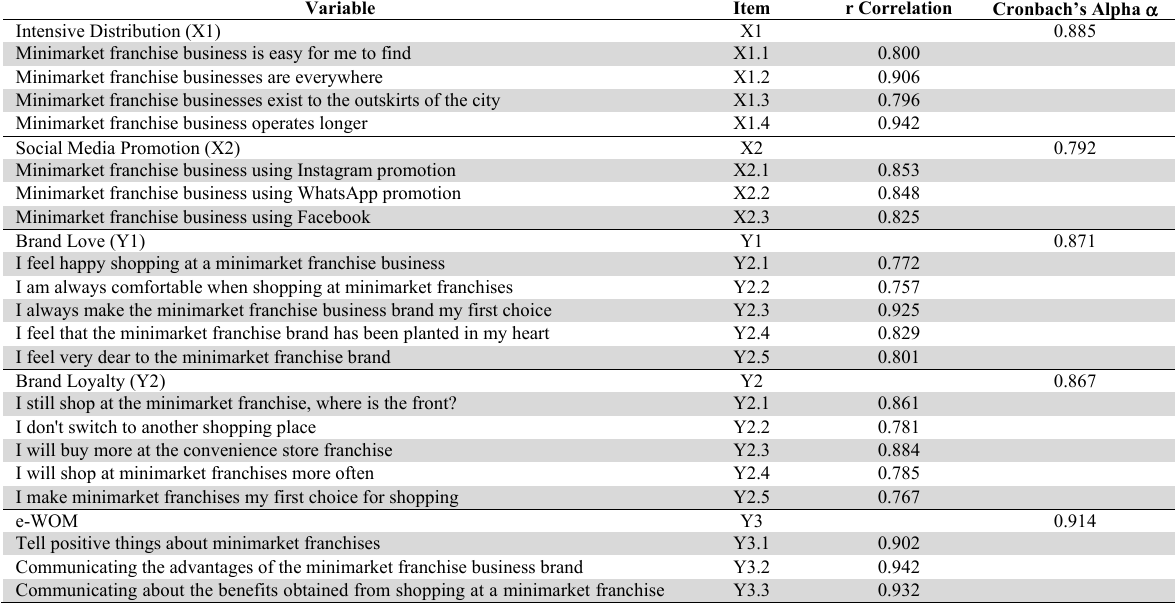
Instrument Validity and Reliability Test Results